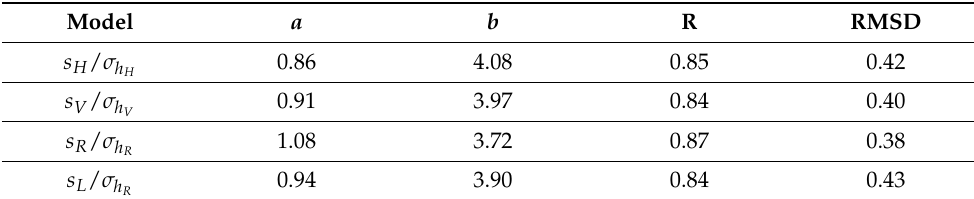
Table 6. Coefficients and correlation between the model described by Equation (26).